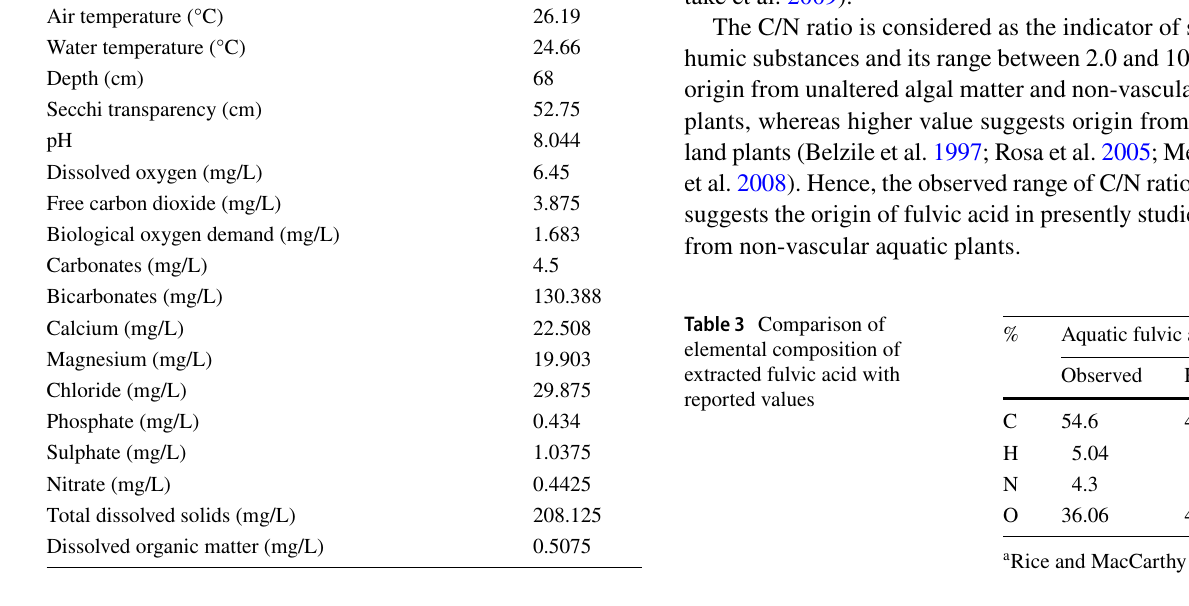
Table 2 Elemental composition (%) and atomic ratios of isolated fulvic acid